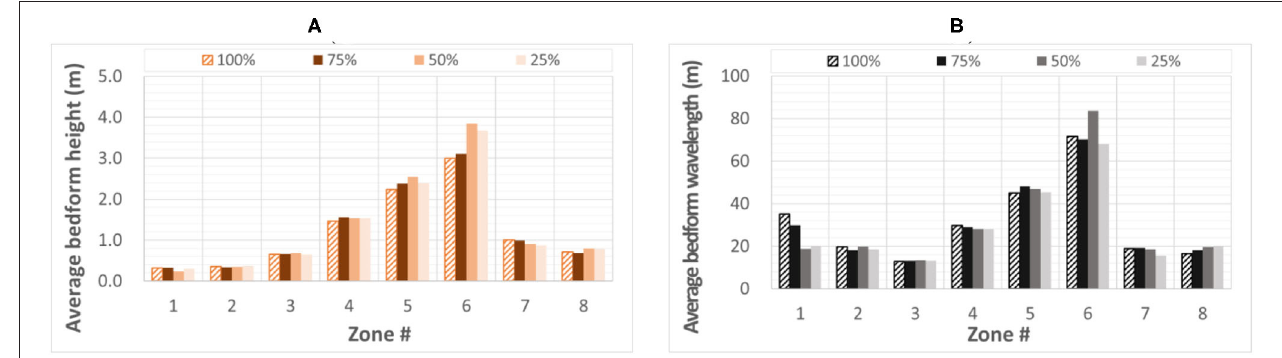
FIGURE 5 | Sensitivity of the bedform characteristics to the number of images used to extract the information: (A) average bedform height; (B) average bedform